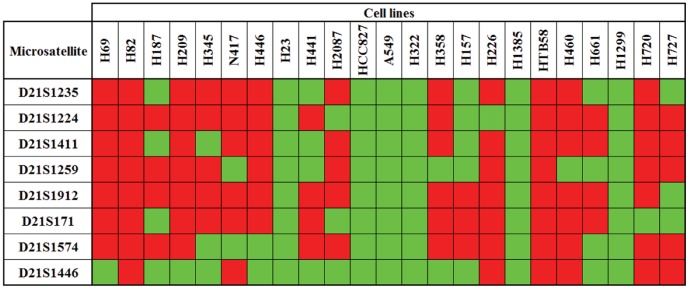
Analysis of microsatellites at 21q22.3 in lung cancer cell lines.Homozygosity (green) or heterozygosity (red) was determined in each cell line. Microsatellites are ordered from the most centromeric to the most telomeric. ADAR2 locus is located within D21S171 and D21S1574.